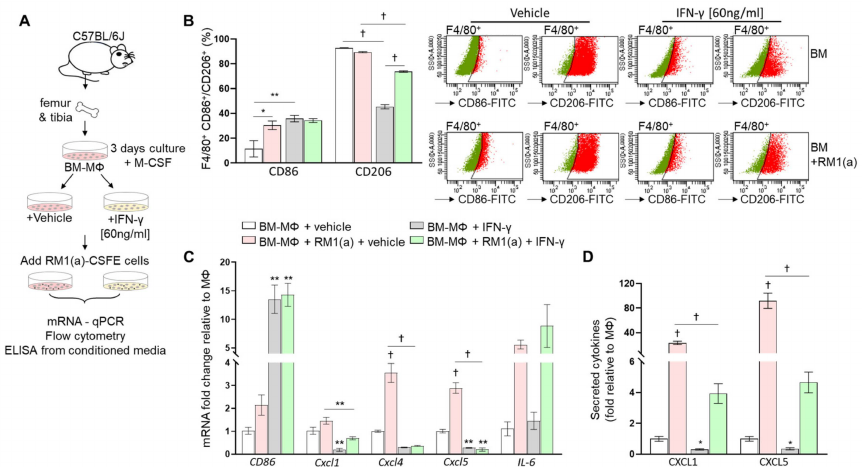
Figure 4. E ff ect of interferon- γ (IFN γ )-M1 polarization of bone marrow-derived macrophages in inflammatory cytokine expression. ( A ) Workflow: BM-M Φ s were isolated and enriched in M-CSF RM1(a) cells for 16–18 h. ( B ) BM-M Φ s alone and in co-culture with RM1(a) cells were stained for anti-F4 / 80-APC combined with either anti-CD86-FITC or anti-CD206-FITC and analyzed by flow cytometry. ( C ) mRNAs from ( A ) were isolated and analyzed by qPCR for the specified inflammatory cytokine genes. ( D ) Conditioned media from ( A ) were analyzed via ELISA for total CXCL1 and CXCL5 levels. Data are mean ± SEM, n = 3 per group; * p < 0.05, ** p < 0.01, † p < 0.0001 (one-way ANOVA; Dunnet’s multiple-comparisons test and unpaired t